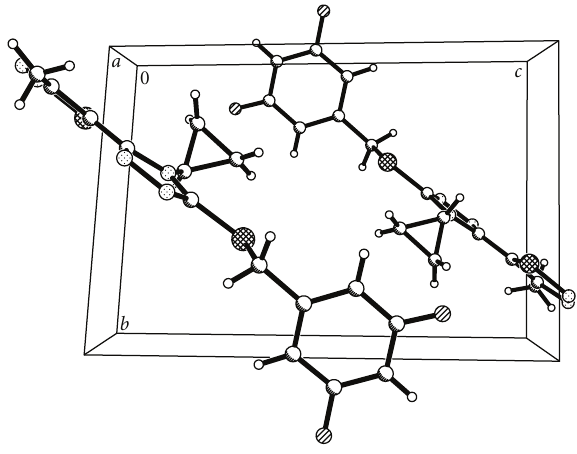
probability level. %